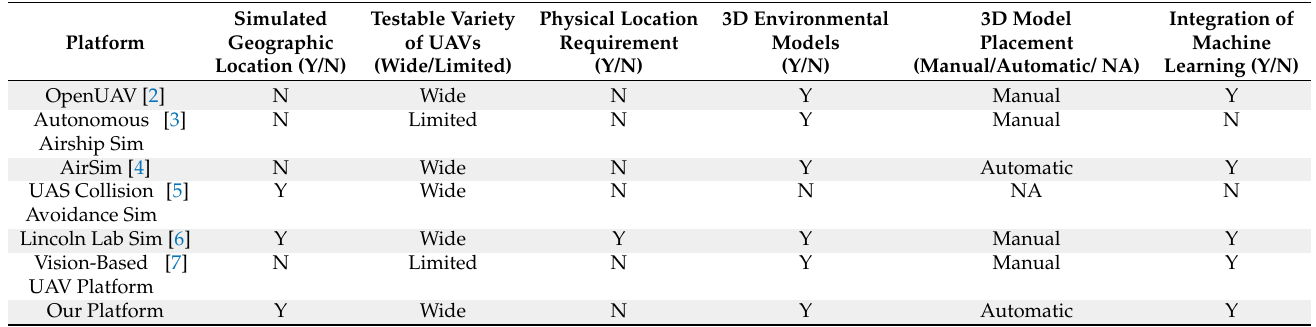
Table 3. Comparison